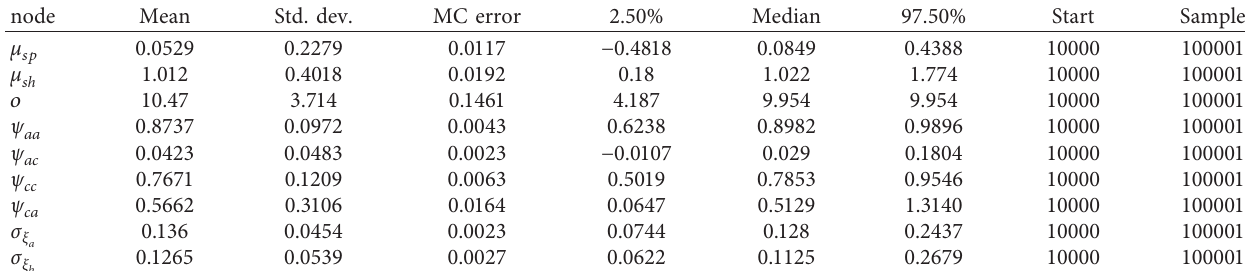
Table 2: The simulation results of posterior